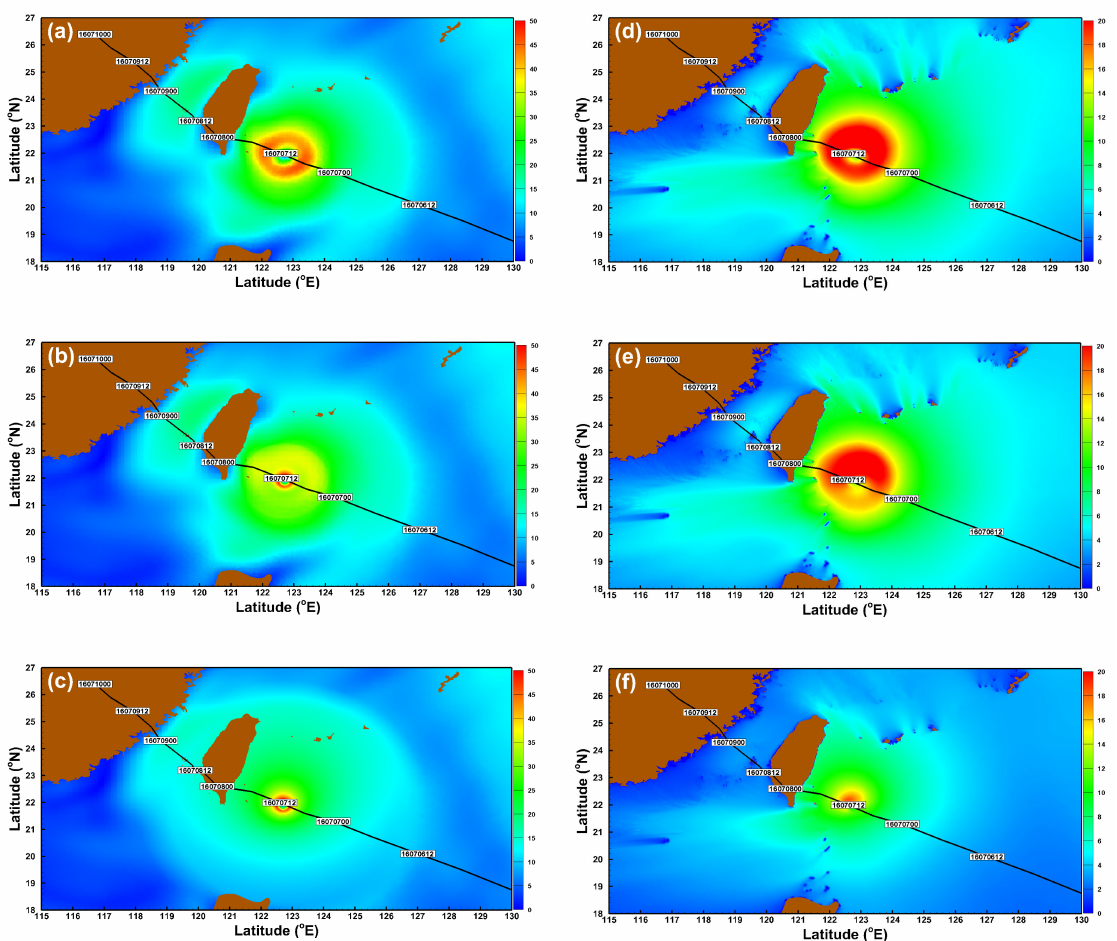
Figure 8. Instantaneous wind field distribution from the ( a ) hourly CFSV2 with a spatial resolution of 0.205 ◦ , ( b ) CFSV2_0.205D_1hr_H1, and ( c ) CFSV2_0.205D_1hr_H2 and their corresponding SWHs ( d – f ) for Super Typhoon Nepartak at 11:00 on 12 July in